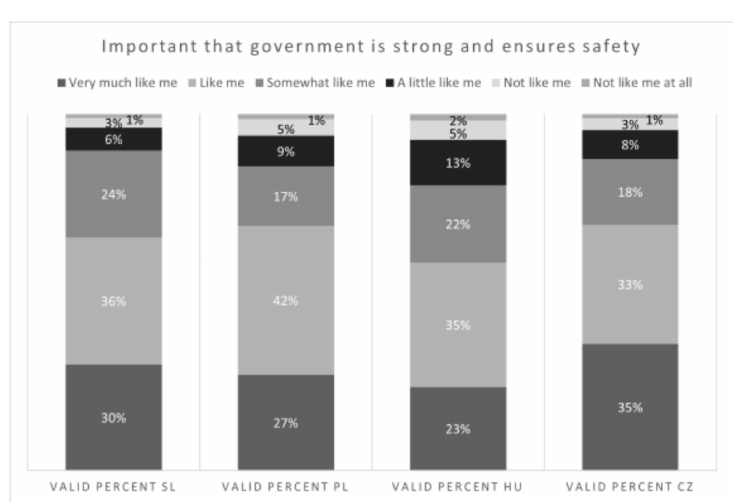
Figure 9. Responses regarding the importance of following rules.